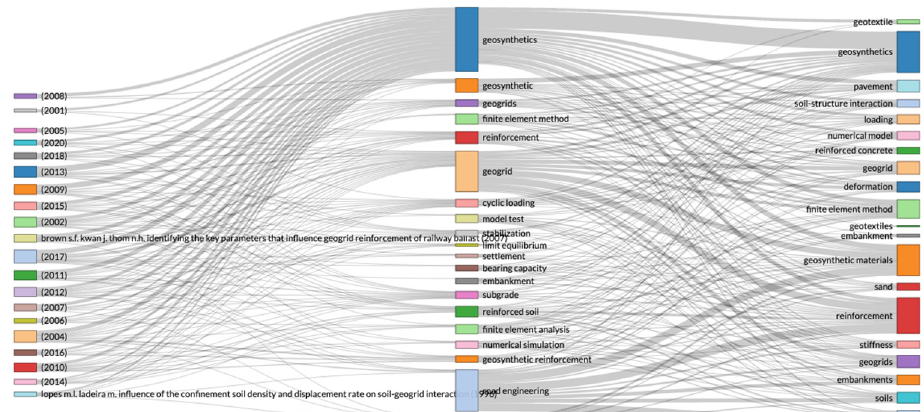
Figure 18. 3-field Figure 18. 3-field plot. Figure 18. 3-field plot.